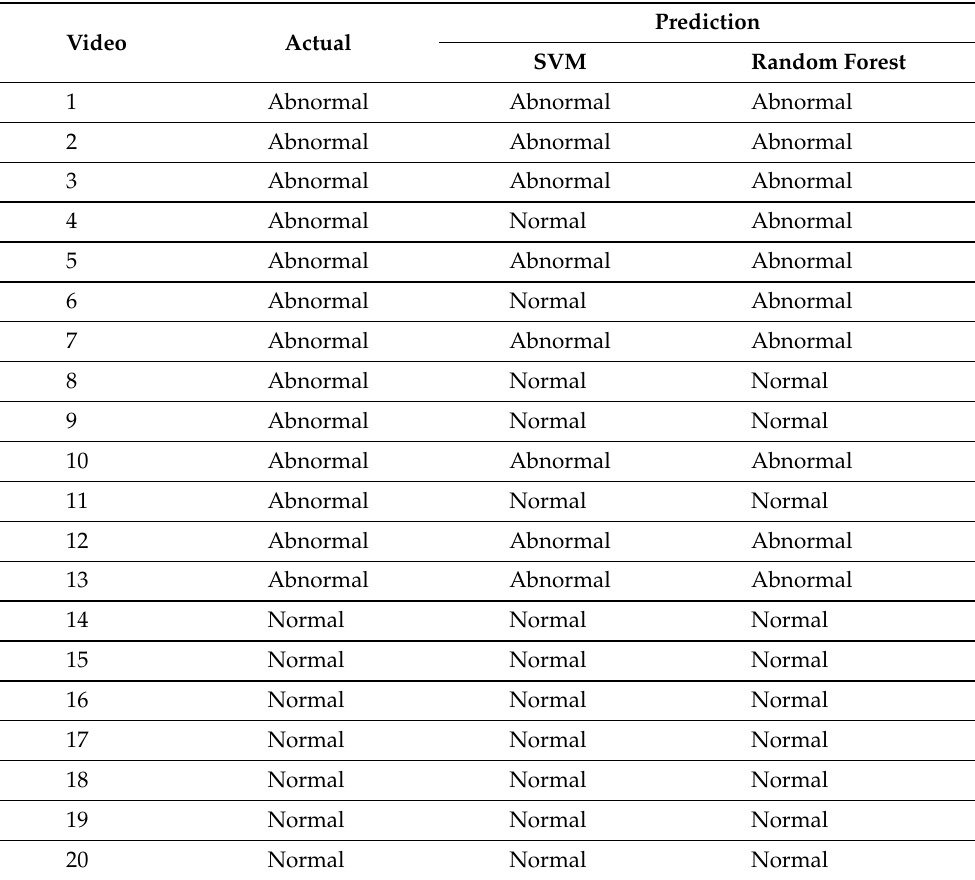
Table 5. Experiment on video